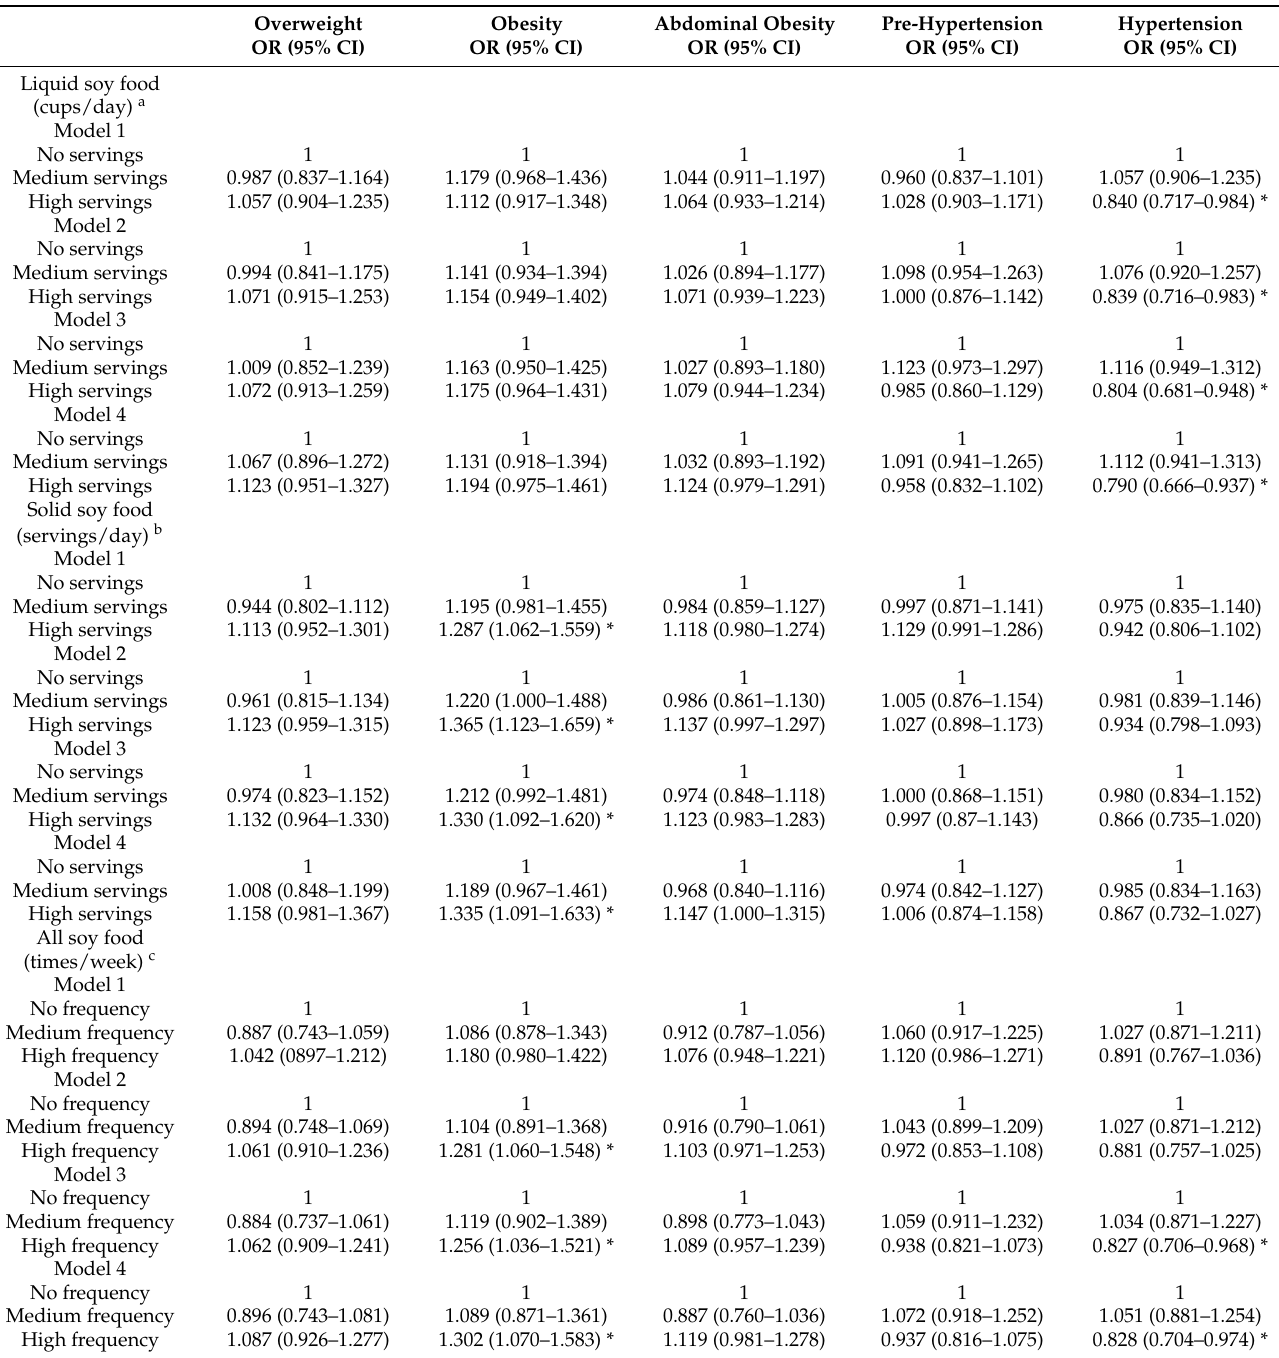
Table 4. Odds ratios (95% confidence intervals) for obesity and hypertension across soy food in- take